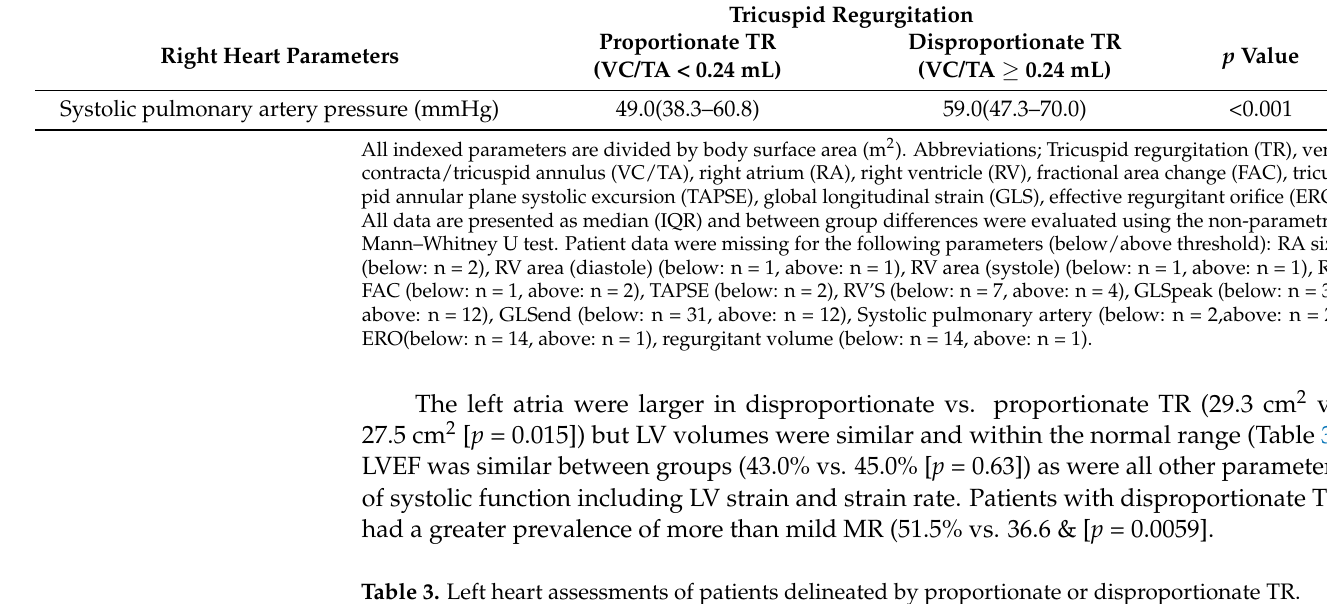
Table 3. Left heart assessments of patients delineated by proportionate or disproportionate